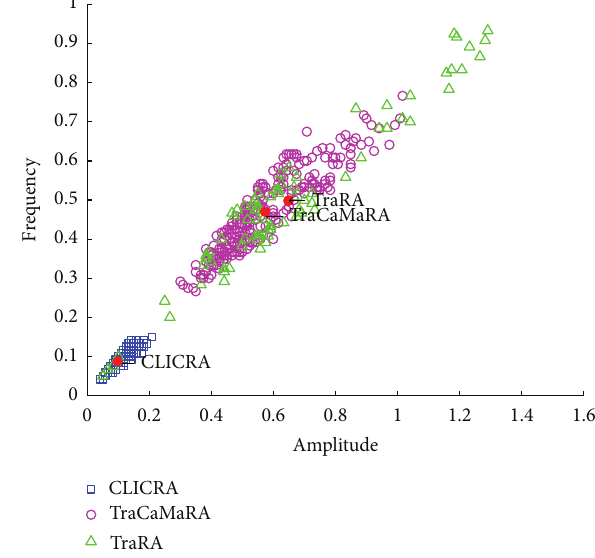
Figure 5: Switch frequency and